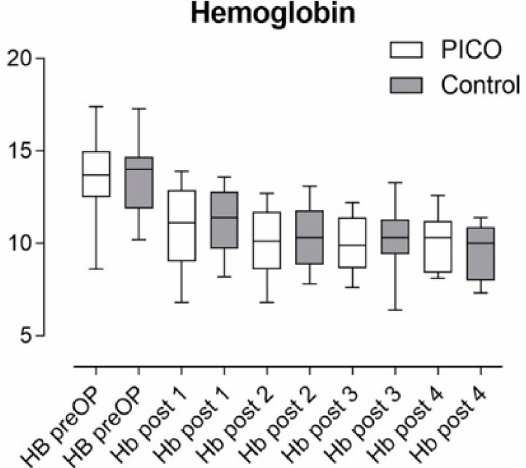
Figure 6. Hemoglobin change over observation time. Shown is the mean with error bars indicating 95% confidence